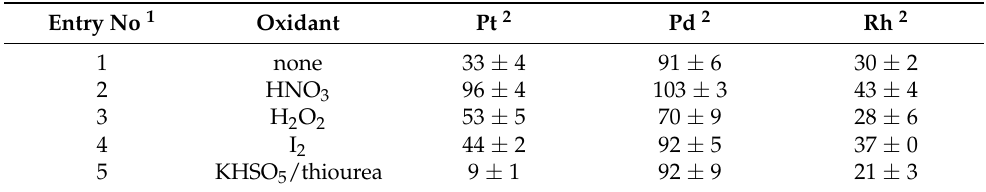
Table 1. PGM extraction efficiencies (%) using the system choline chloride/pTsOH/HNO 3 with various